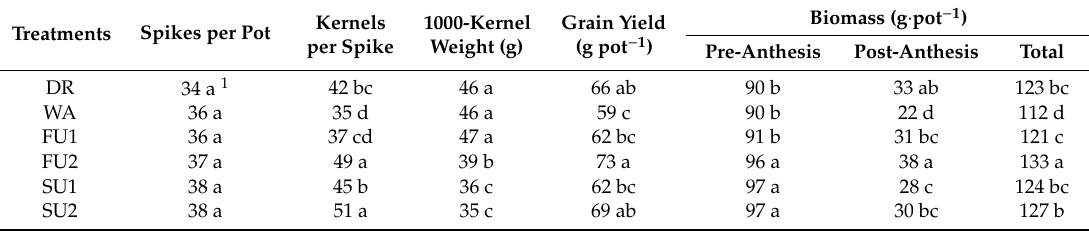
Table 1. E ff ects of urea applied after waterlogging on grain yield, yield components, and biomass in wheat. DR, water drainage treatment; WA, waterlogging